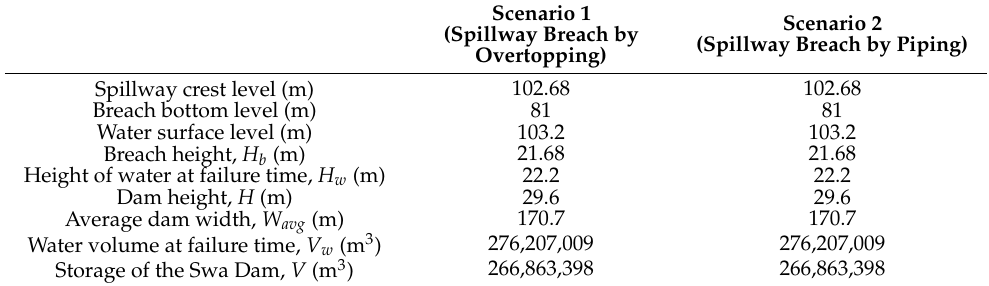
Table A4. Input data set for the parameters of the Swa Dam breach for different